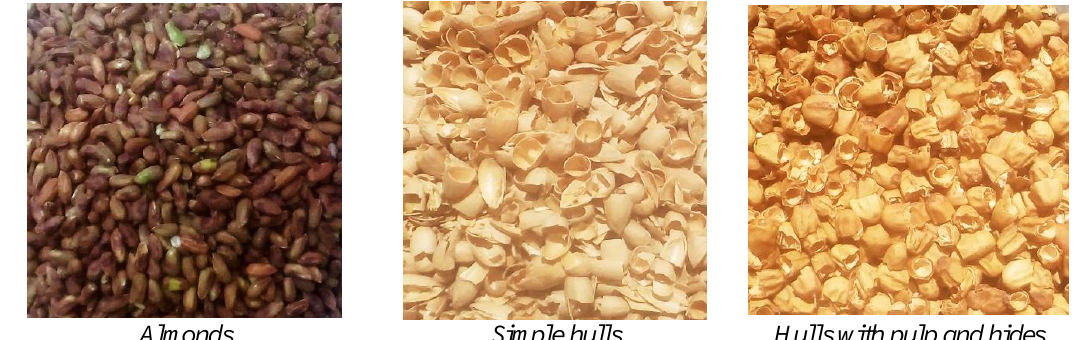
Hulls with pulp and hides